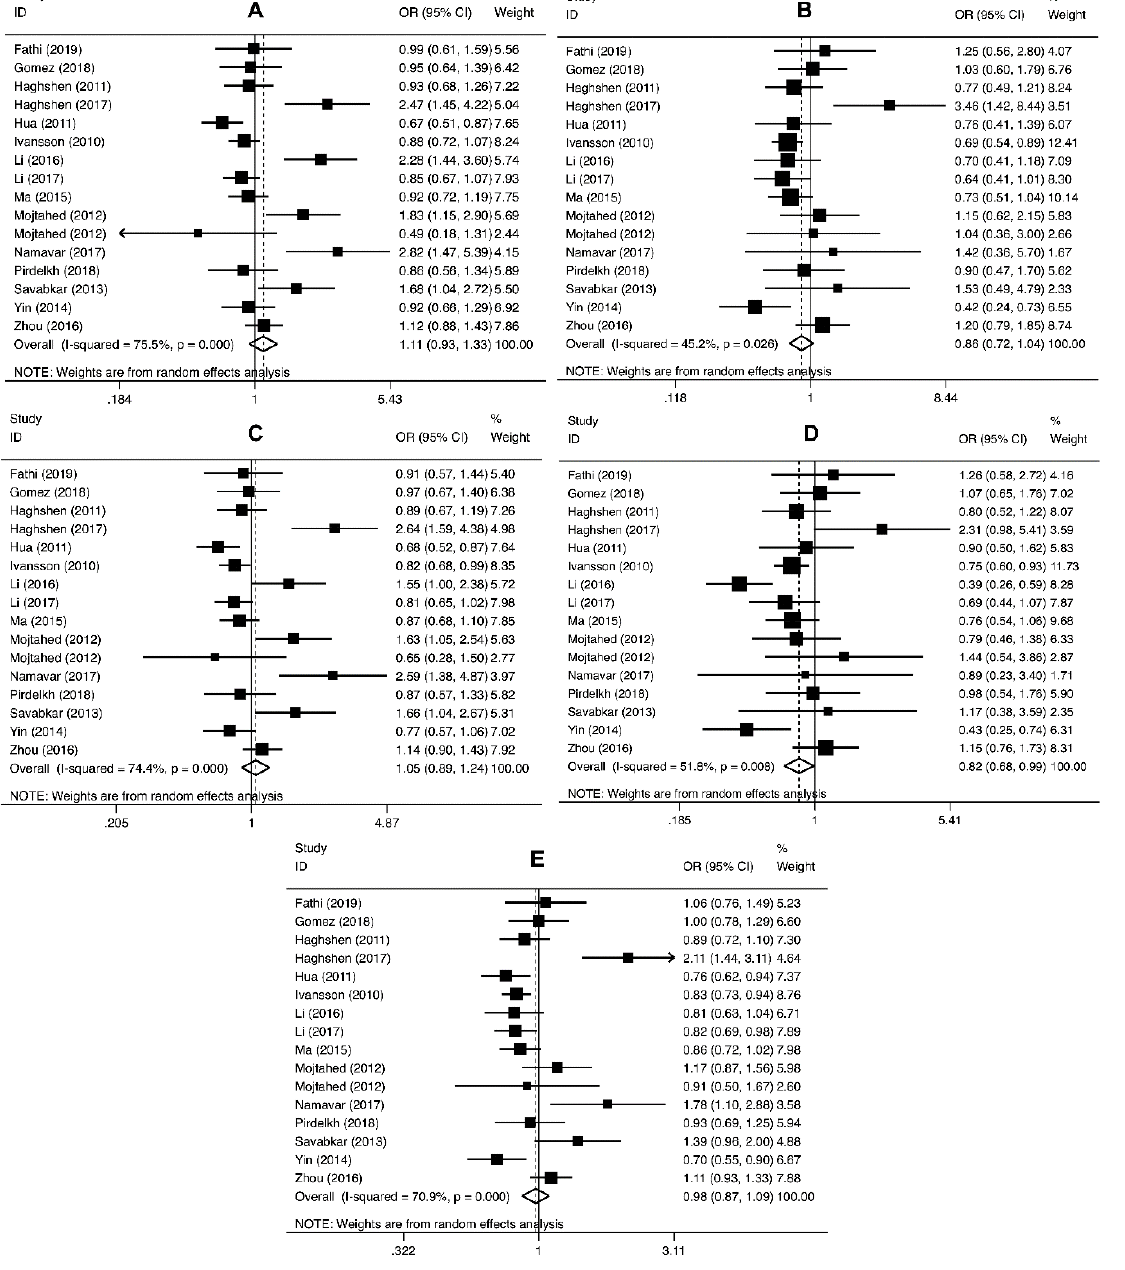
Figure 2. Forest plot for the association between PD-1 rs2227981 polymorphism and cancer susceptibility for CT vs. CC ( A ), TT vs. CC ( B ), CT + TT vs. CC ( C ), TT vs. CT + TT ( D ), and T vs. C ( E ).